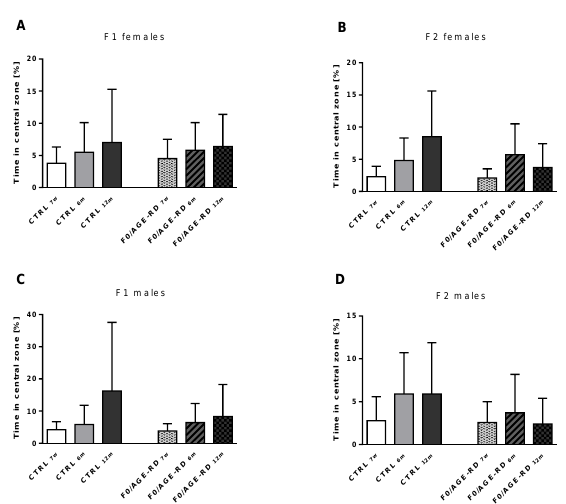
Figure 3. Percentage of time spent in the central zone of the open field test. F1 females ( A ), F2 females ( B ), F1 males ( C ), F2 males ( D ). GLM (3 × 2 × 2 = age, F0 diet, generation), females: F (2, 90) = 9.4, p < 0.001; males: F (1, 63) = 5.2, p = 0.017; age and F0 diet and age, F0 diet and generation interactions not significant in either sex. Values are presented as mean + standard deviation. CTRL = groups fed with control chow, F0/AGE-RD group = F1 and F2 offspring of F0 dams fed with diet rich in advanced glycation